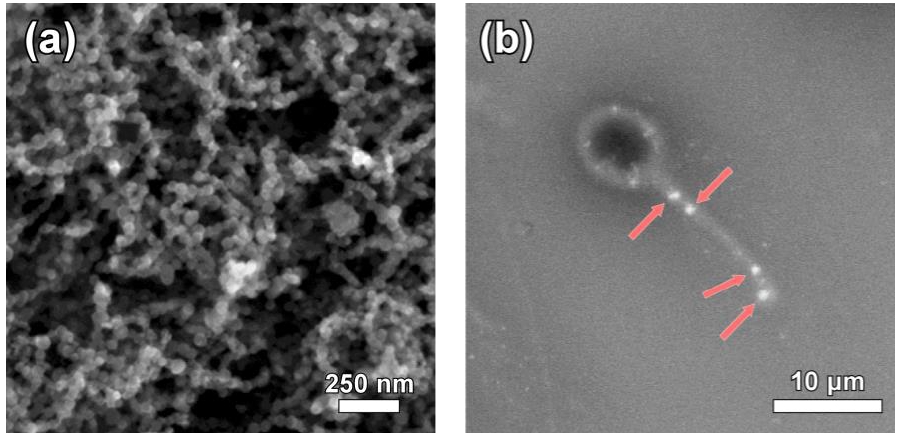
Figure 3. Scanning electron microscope (SEM) image of the synthesized Fe 3 O 4 nanoparticles ( a ) and representative picture of nanoparticles attachment on a spermatozoon after incubation ( b ).